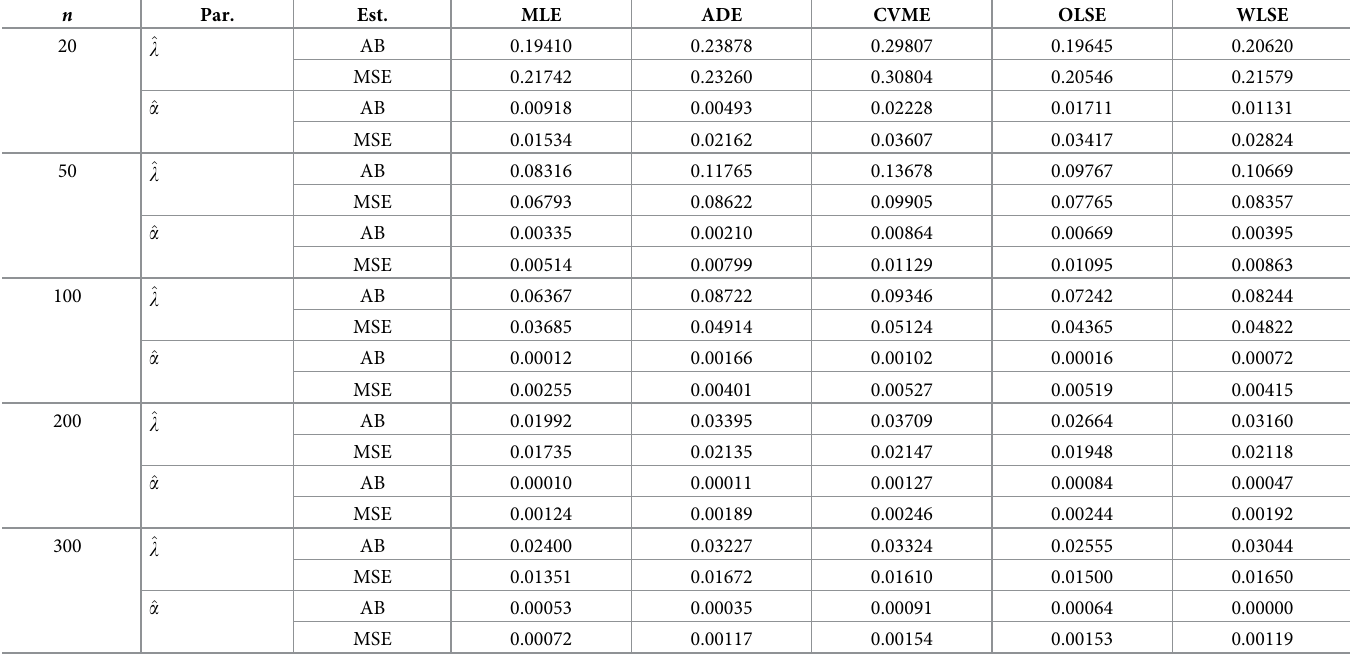
Table 2. Simulation results for ( λ = -0.9, α = 0.5). n